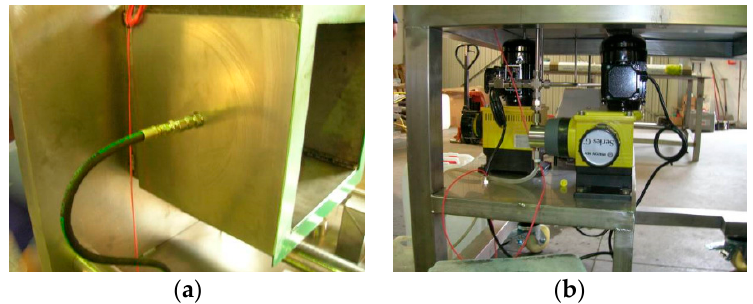
Figure 3. ( a ) Method of fluid injection inside the camera; ( b ) Details for two metering pumps “Dosapro” (yellow).